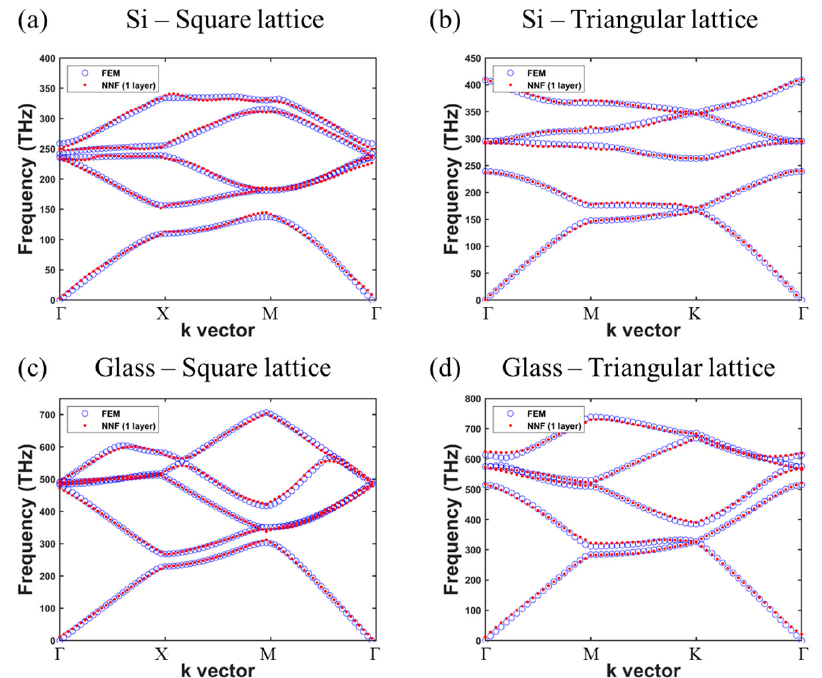
Figure 5. FEM-calculated (blue circles) and predicted (red dots) band structures of PCs made of Si in ( a ) square lattice and ( b ) triangular lattice and glass in ( c ) square lattice and ( d ) triangular lattice with r/a = 0.45 and 25 neurons in the hidden layer.